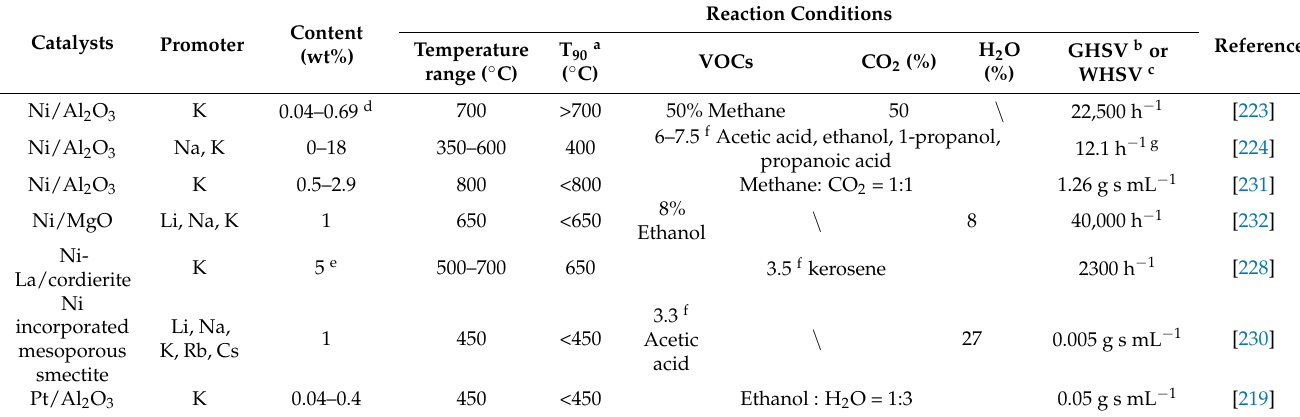
Table 11. Summary of catalysts and reaction conditions for reforming catalysts promoted by alkali metals.